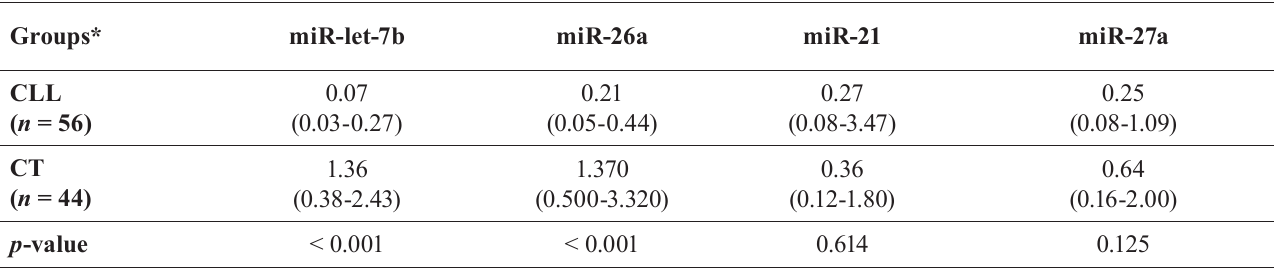
TABLE IV - miRNA gene expression in patients with CLL and controls G